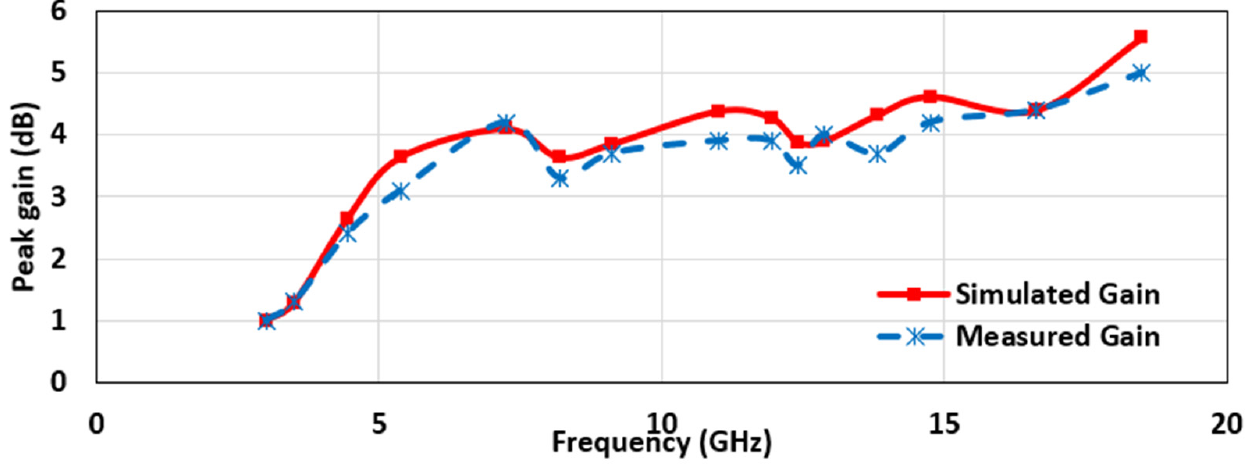
Figure 9. The simulated and measured peak gain plot as a function of frequency.